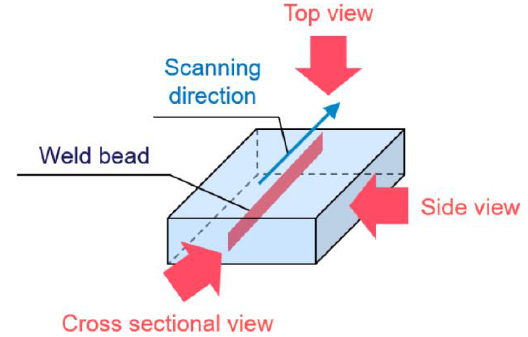
Figure 3. Schematic illustration of observation direction by optical microscope. Table 2. Specifications of laser oscillator.